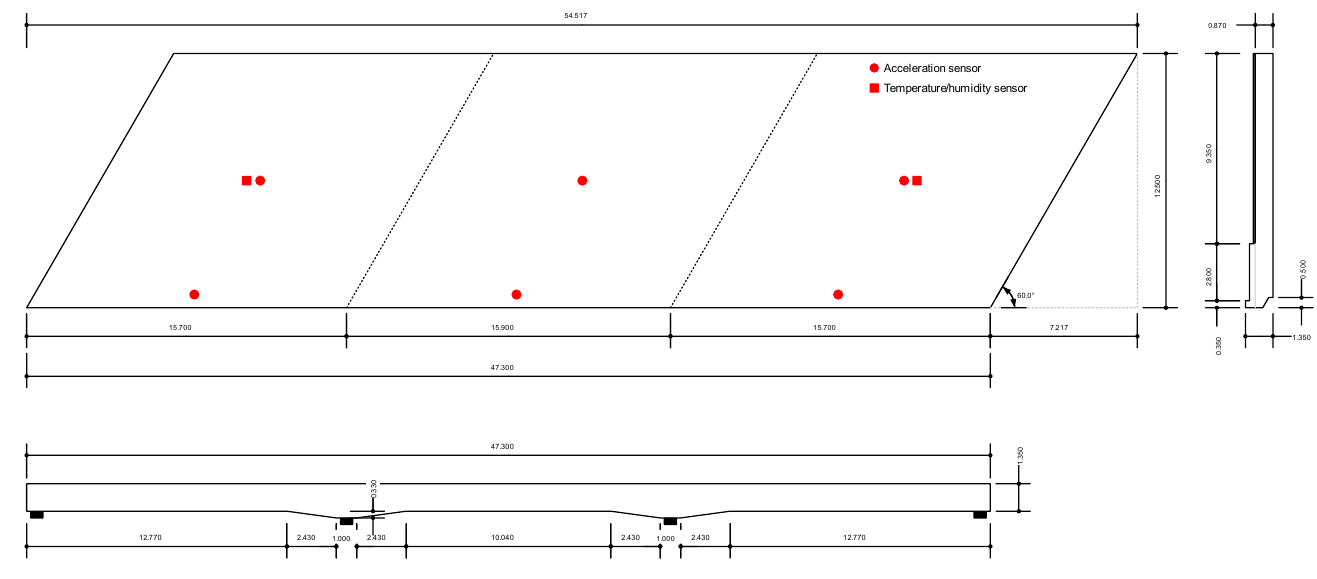
Figure 3. Shape and sensor layout of Seolmun Bridge.